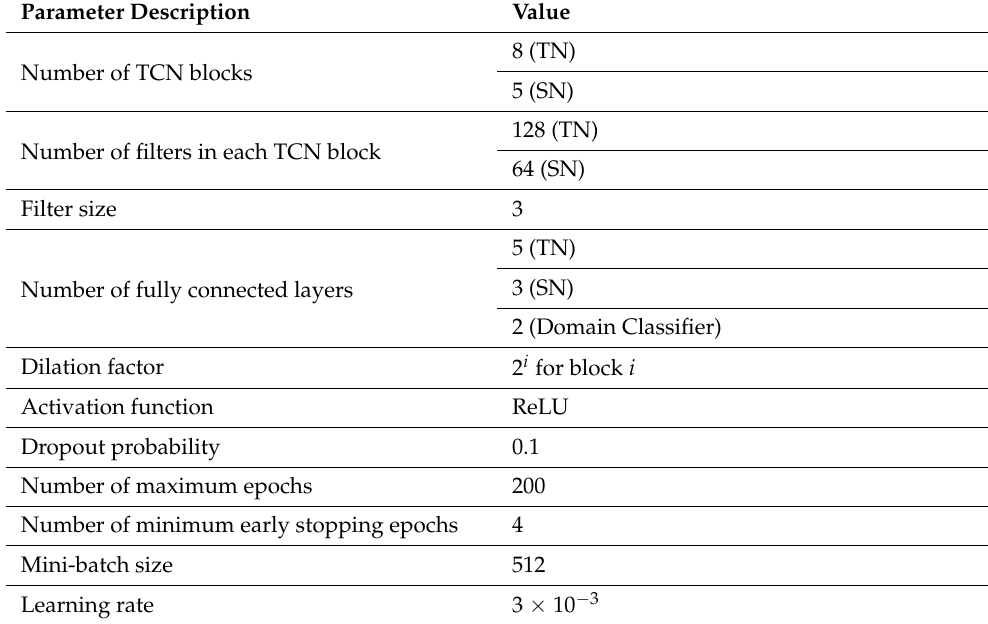
Table 2. Training